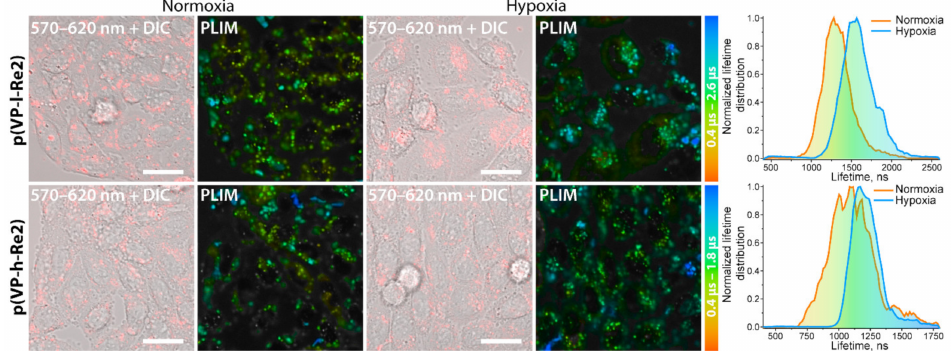
Figure 9. Confocal images ( λ ex = 405 nm, λ em = 570–620 nm) merged with differential interference contrast (DIC), PLIM images of CHO-K1 cells incubated with p(VP-l-Re2) and p(VP-h-Re2) at a concentration of 5 µ M of Re complex under normoxia and hypoxia conditions, and lifetime distributions for corresponding PLIM